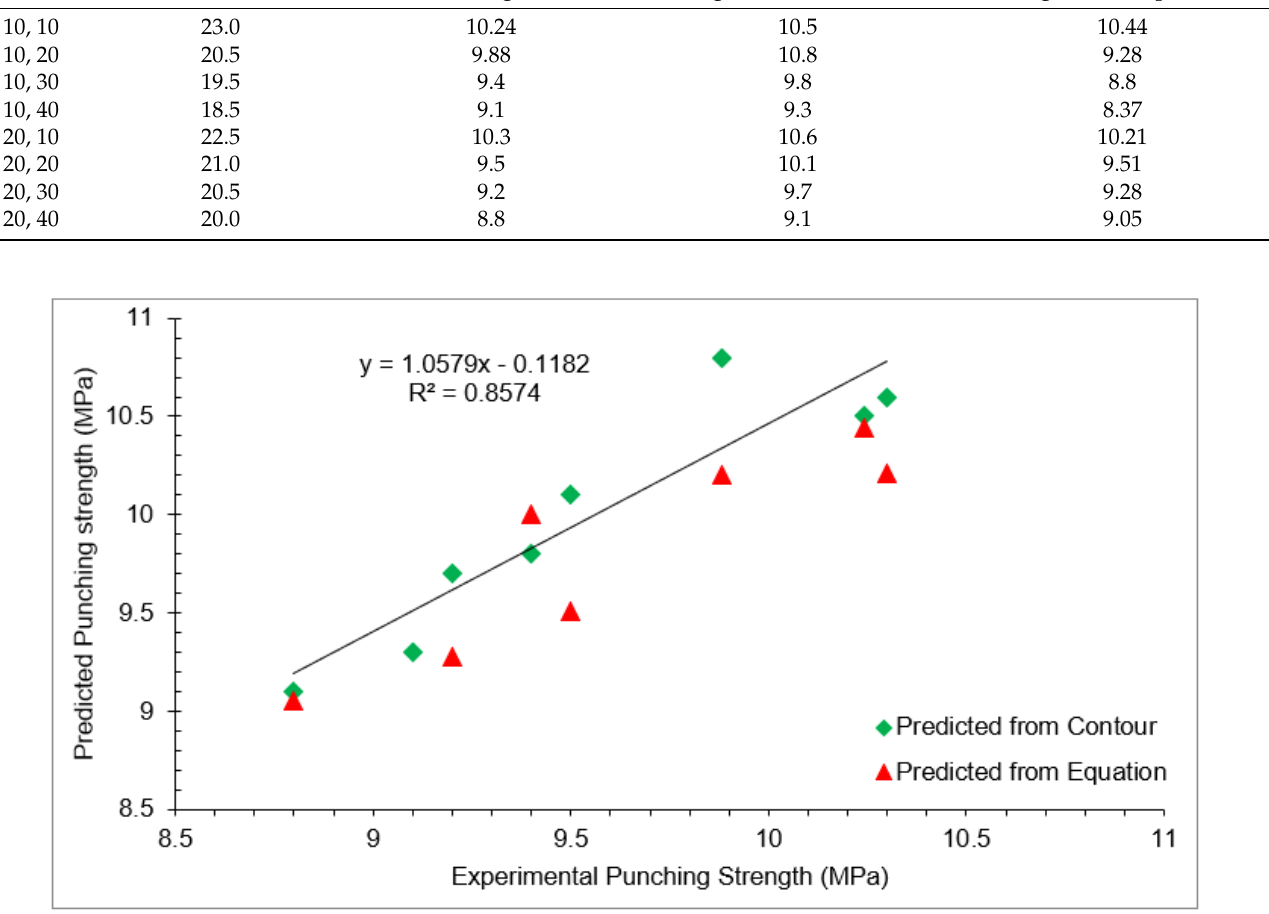
Figure 21. Correlation between experimental and predicted punching